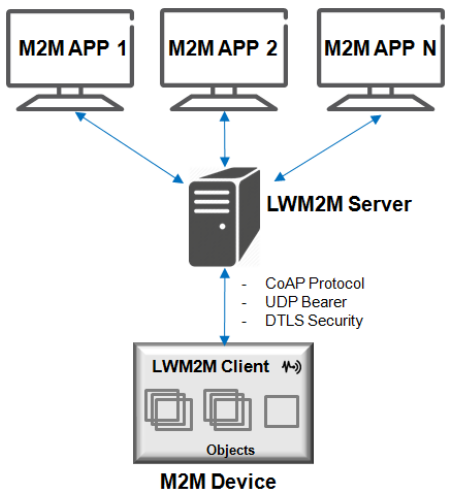
Figure 18. OMA LWM2M standard management